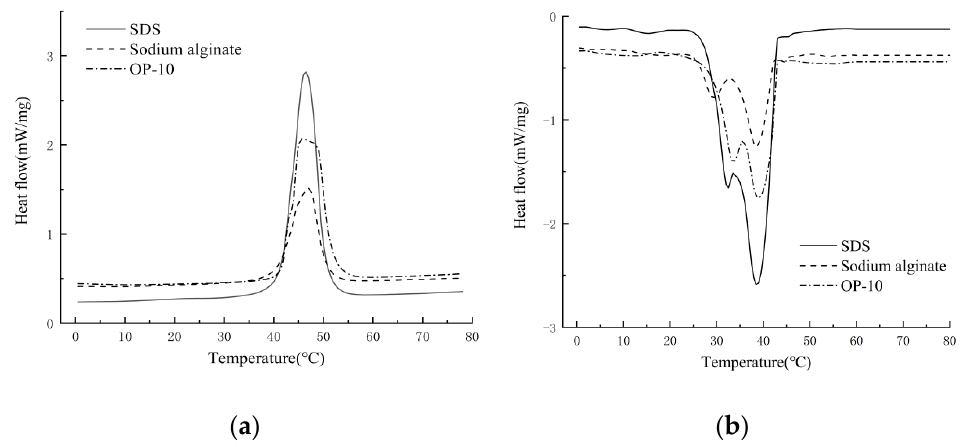
Figure 5. DSC curves of the MPCMs prepared with different emulsifiers in a ratio of 0.22%, ultrasonic oscillation time of 10 min, pH of 4.5, and core–shell ratio of 1:1. ( a ) Melting and ( b ) crystallization processes at a temperature rate of 10 K/min in a 60 L/min flow of N 2 . Table 5. Experimental results for changing type of emulsifier.